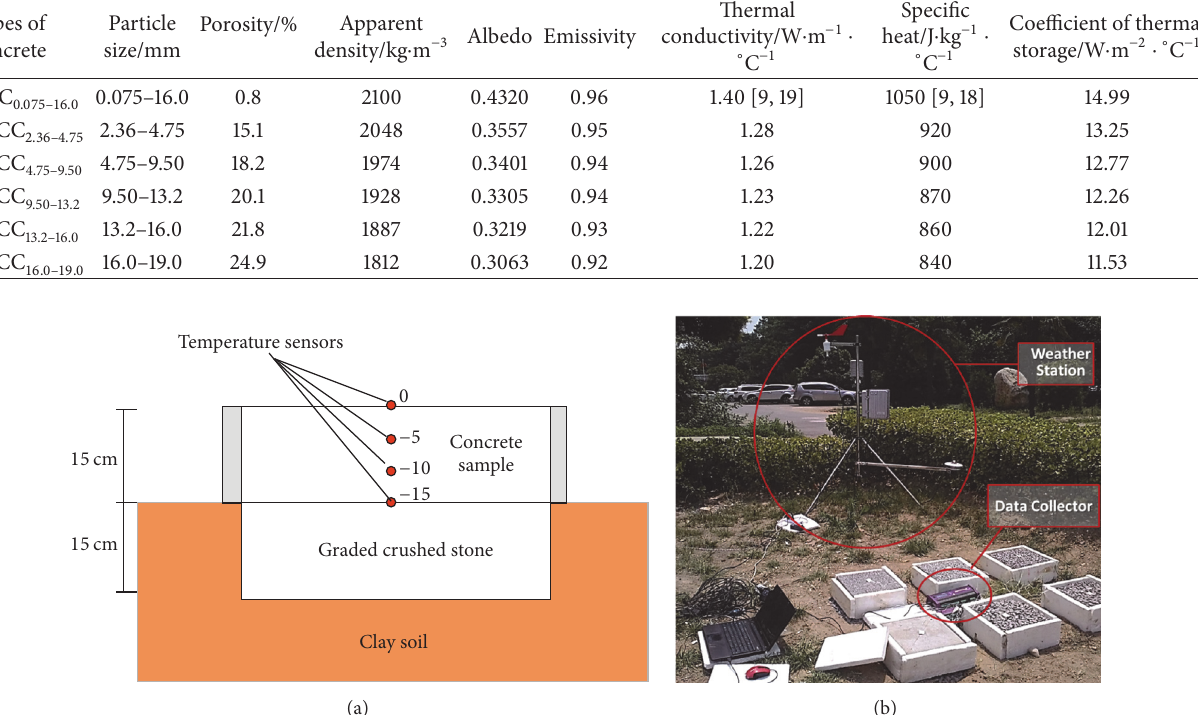
Table 1: Parameters of concrete.